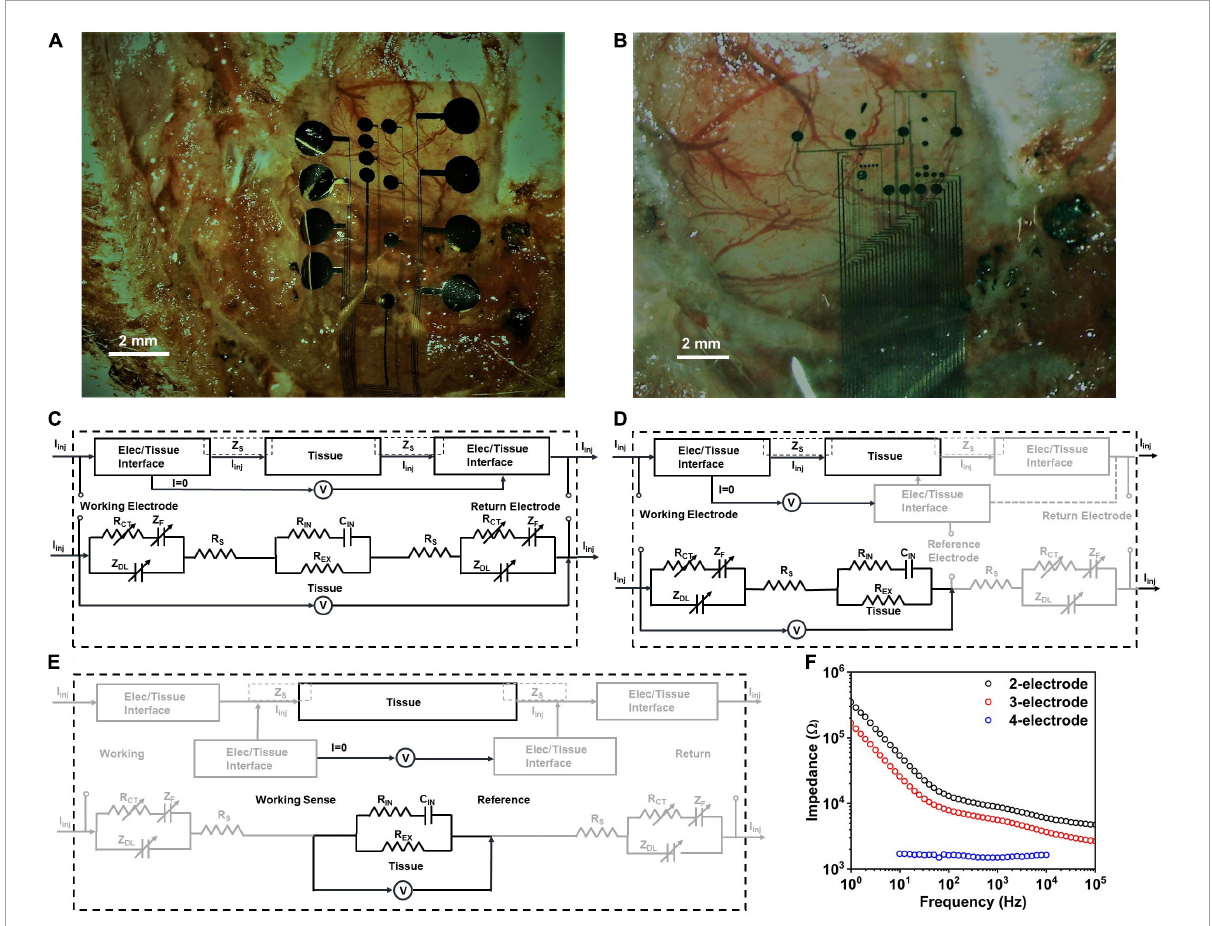
FIGURE2 Electrode positioning in vivo for (A) small contact and (B) large contact arrays. The observed impedance elements in (C) 2-contact, (D) 3-contact and (E) 4-contact electrochemical impedance spectroscopy (EIS) measurements, in vivo . (F) Electrochemical impedance spectra in vivo for a PtNR contact with a diameter of 200 µ m in the 2-, 3-, and 4-contact